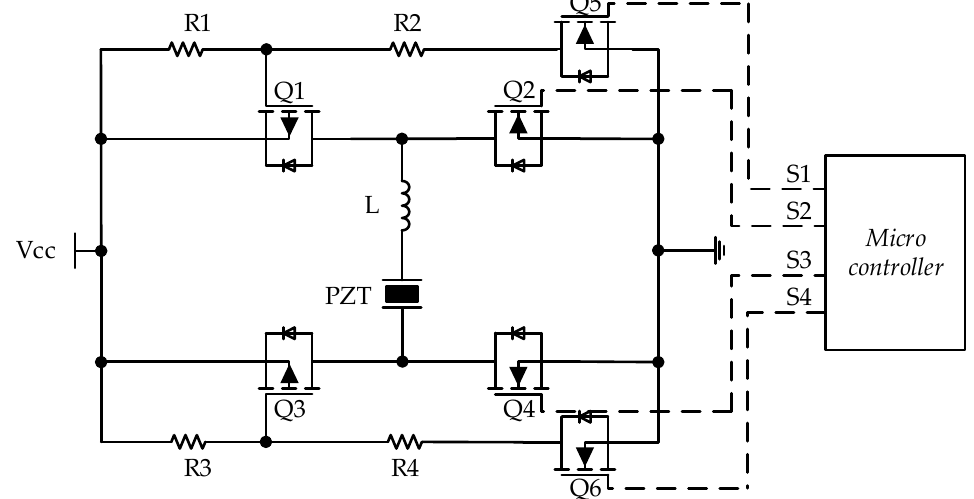
Figure 6. Single inductor-based driving (SID) circuit.